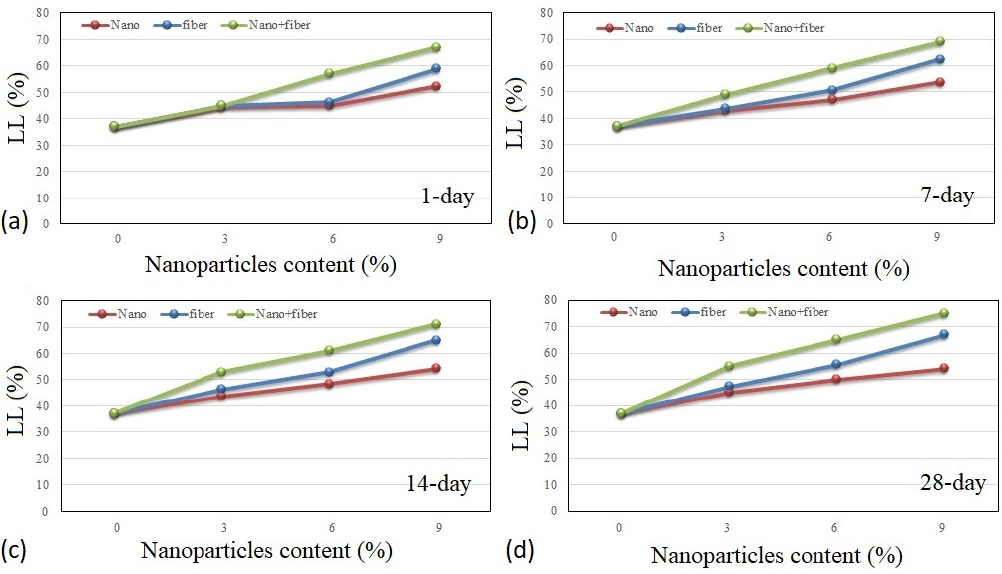
Figure 6. Liquid limit results were measured for different groups of the samples: ( a ) 1-day, ( b ) 7-day, ( c ) 14-day, ( d ) 28-day.